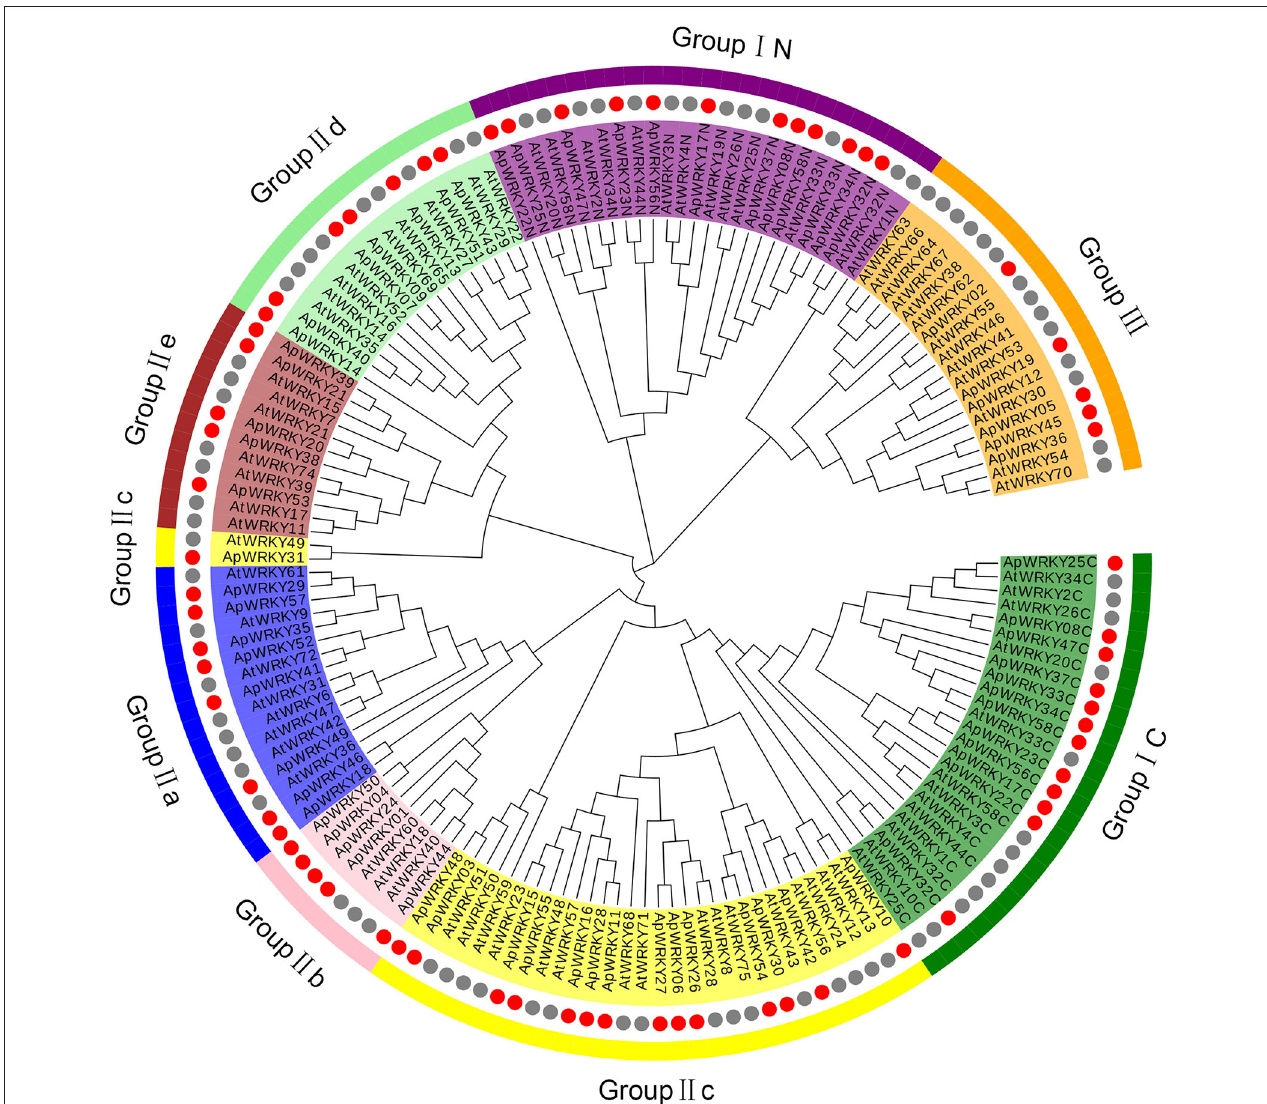
FIGURE 3 | Phylogenetic relationships of WRKY proteins from A. paniculata and Arabidopsis using WRKY domain sequences. Groups are